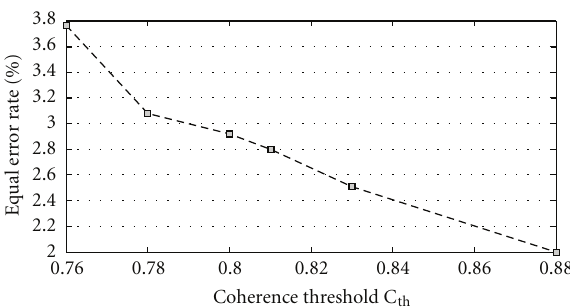
Figure 5: Equal error rates of the template updating algorithm for various coherence thresholds c th